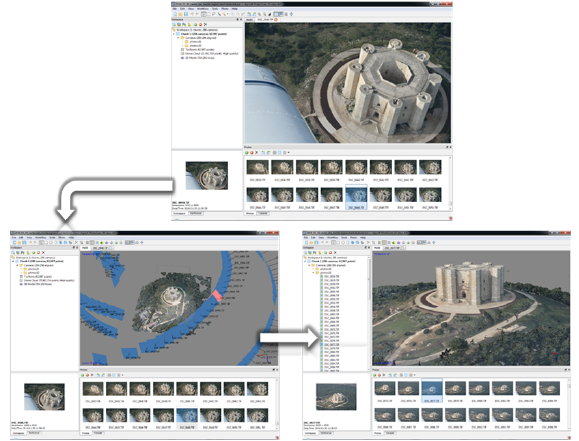
Figure 12. Point cloud in Photoscan